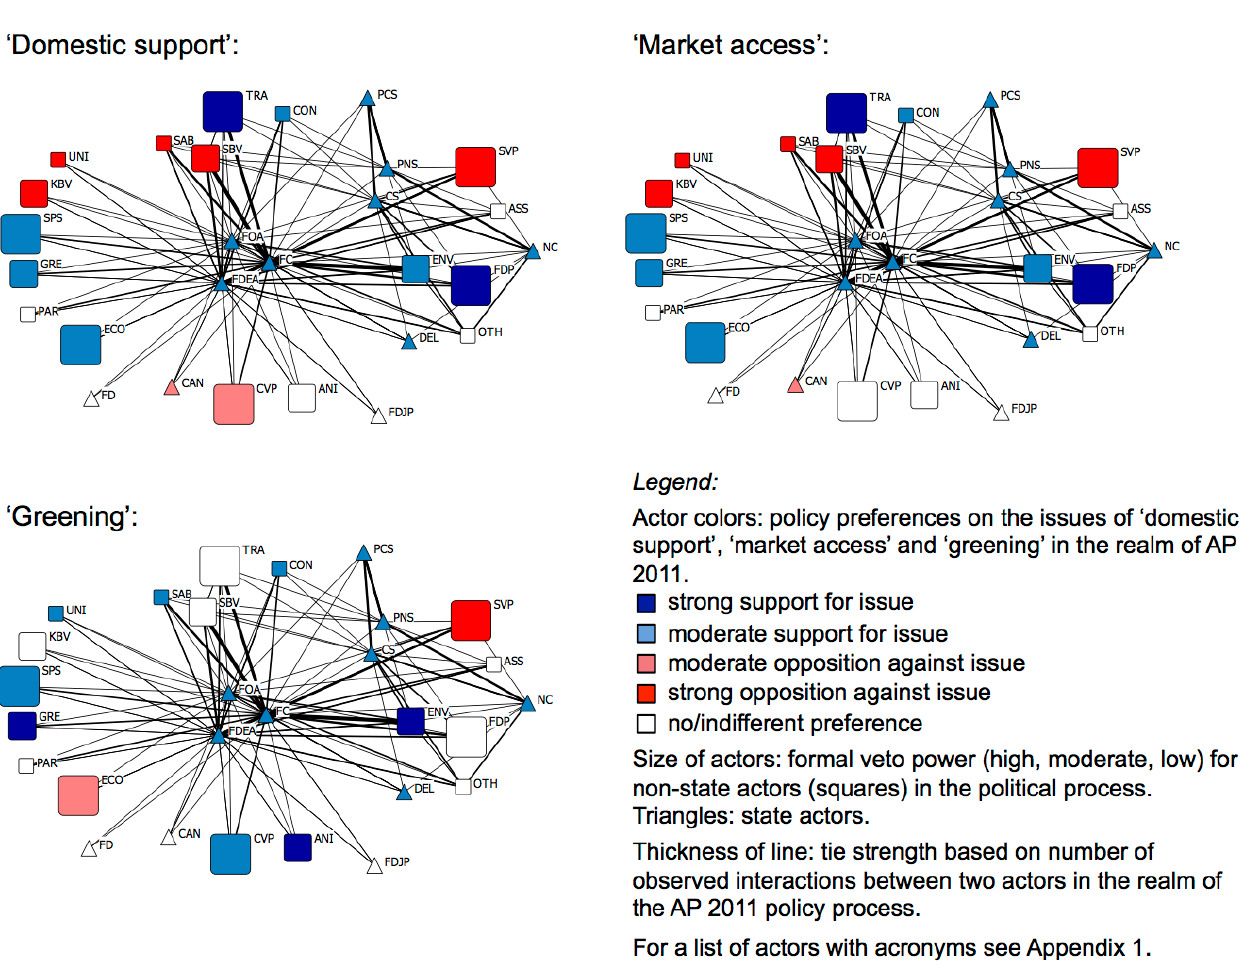
Fig. 2 . Policy network structure and policy